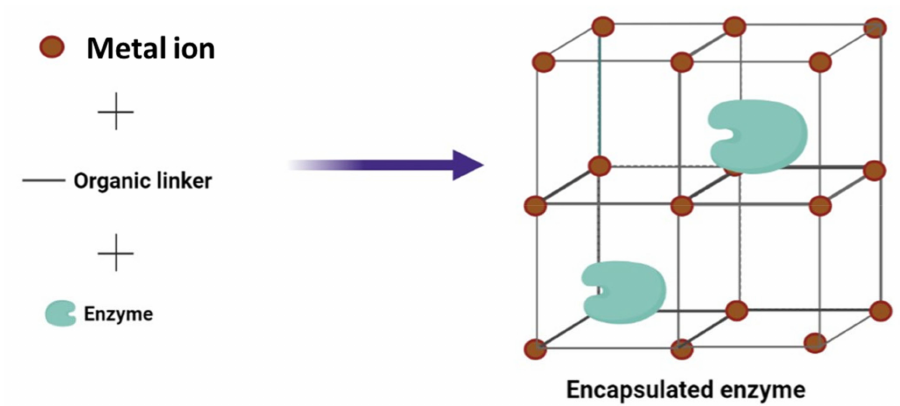
Figure 3. Enzyme encapsulation in metal-organic